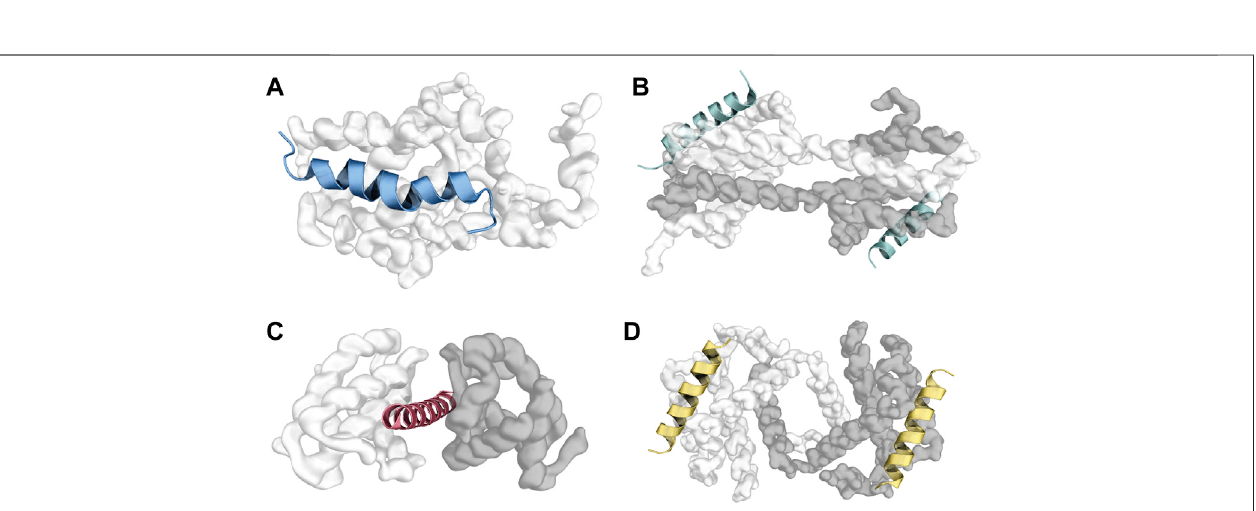
FIGURE3| DifferenttopologieswereobservedincrystalsofhumanBCL2protein/BH3motifcomplexes. (A) representsthecanonicaltopology,withonemolecule oftheBCL2proteinboundtoasingleBH3peptide(PDBID:2M04).Panel (B) and (D) illustratethe “ core/latch ” and “ helix ɑ 1 ” dimers,respectively,wheretwointertwined molecules of the BCL2 protein engage two BH 3 motifs (one each) with their BH3-binding grooves (PDB IDs: 5VWW and 6DCN). Panel (C) depicts the “ sandwiched ” conformation, where one BH3 motif is squeezed between two monomers of the BCL2 protein (PDB ID: